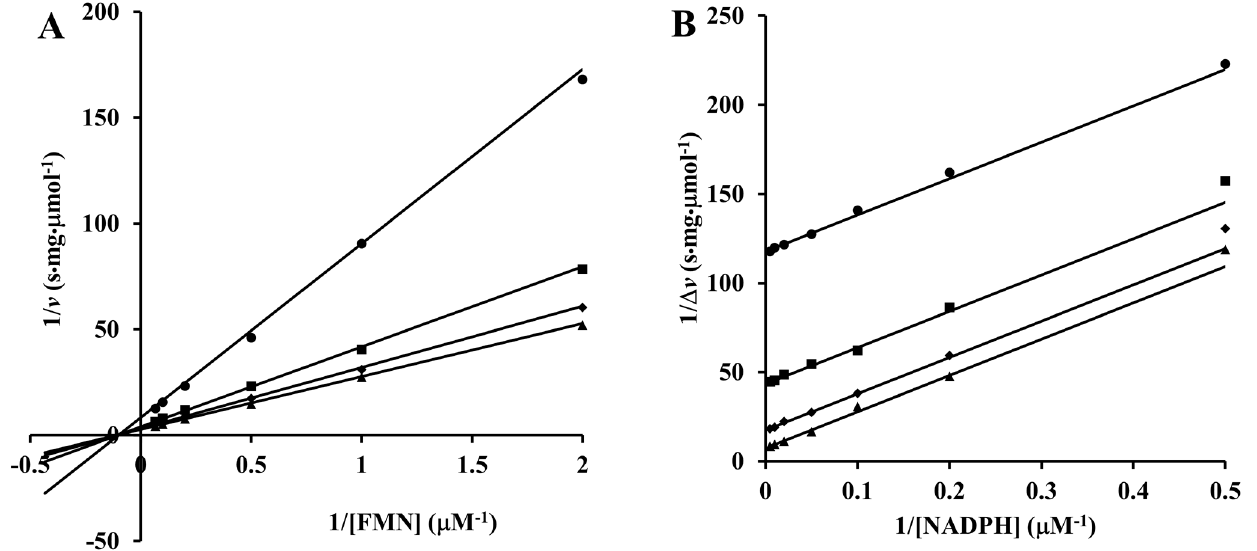
Figure 2. Double reciprocal plots from initial velocity data of the ArsH reactions. Measurements were performed at 30 ◦ C in 0.1 M sodium phosphate buffer (pH 7.0). The reaction was started by the addition of ArsH, and the decrease in absorbance at 340 nm was recorded. Plot ( A ), NADPH:FMN oxidoreductase. ArsH concentration, 205 nM. The fixed concentrations of NADPH are 5 (circles), 20 (squares), 50 (rhombs) and 150 µ M (triangles). Plot ( B ), NADPH:PhAsO(OH) 2 oxidoreductase. ArsH concentration, 1.4 µ M. FMN concentration, 50 µ M. The fixed concentrations of PhAsO(OH) 2 are 10 (squares), 30 (circles), 100 (rhombs) and 1000 µ M (triangles).